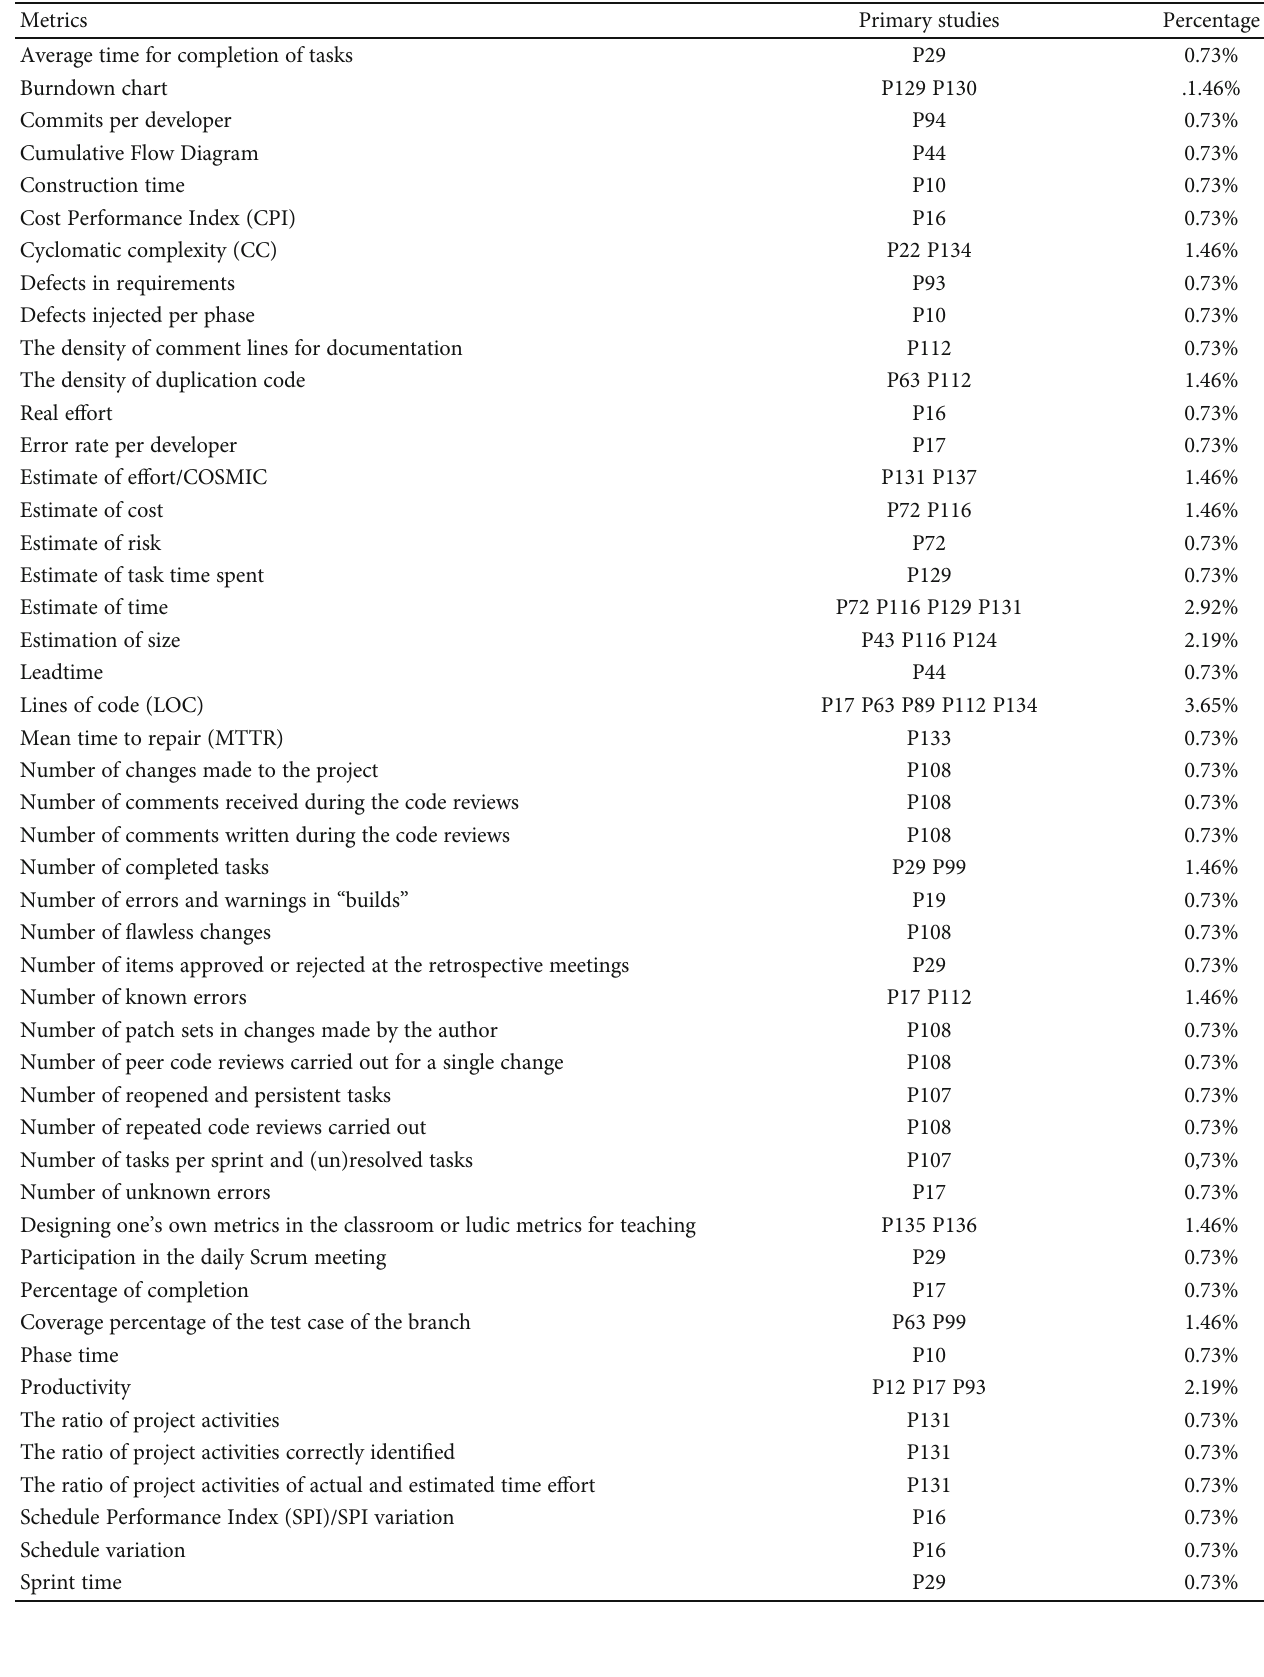
Table 17: Metrics found in the primary